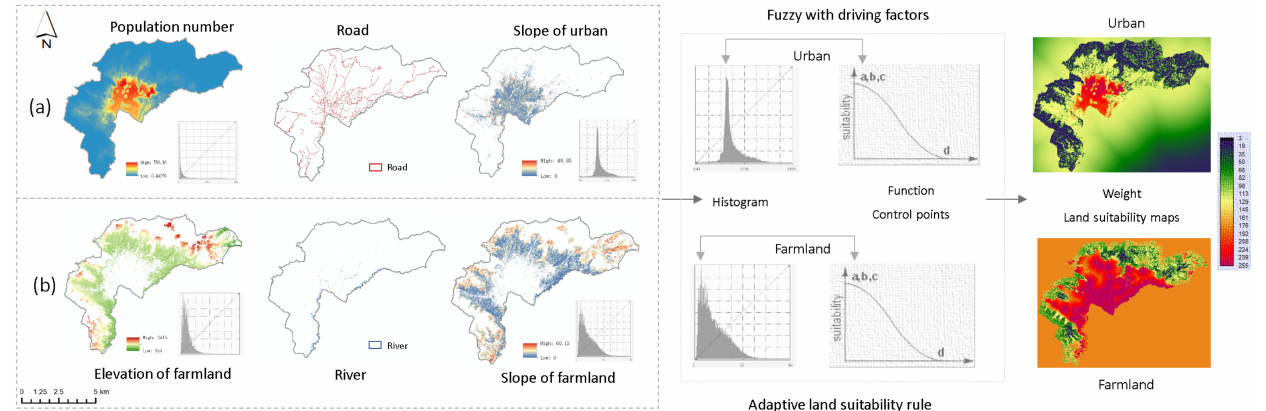
Figure 4. Adaptive land suitability rule with driving factors. Kathmandu is taken as an example. ( a ) Driving factors for an urban area. ( b ) Driving factors for farmland. Note that the figure is utilized to describe the adaptive land suitability rule here, and the determination of driving factors for Nepal is introduced in Section